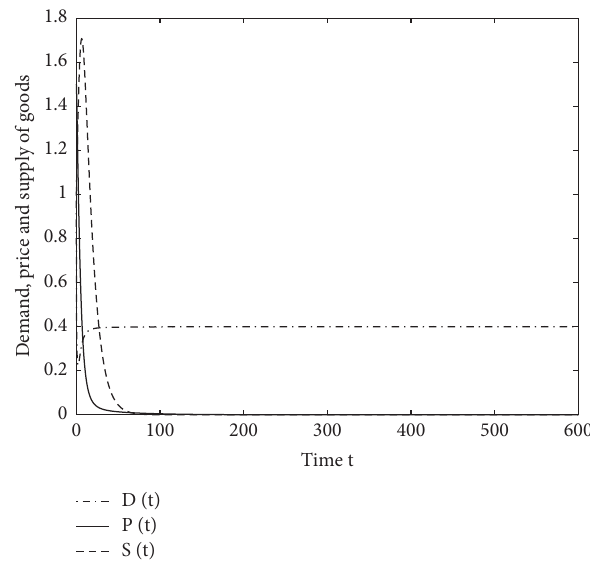
Figure 1: Plane phase diagram of the global asymptotic stability at